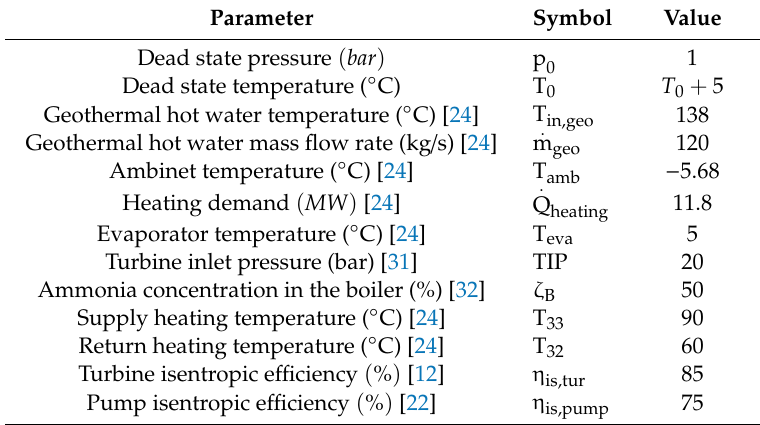
Table 1. Input data and boundary conditions used for design the system and process the